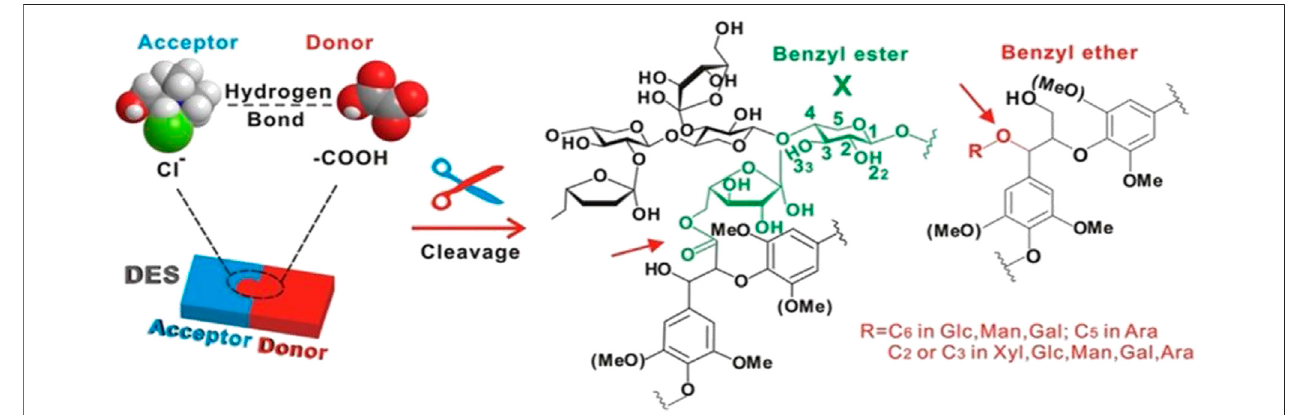
FIGURE 3 | Disruption of lignin carbohydrate complexes with DES. Reprinted from ref. (Satlewal et al., 2018). Copyright 2018 Elsevier